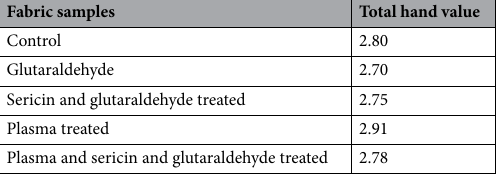
Table 3. Total hand